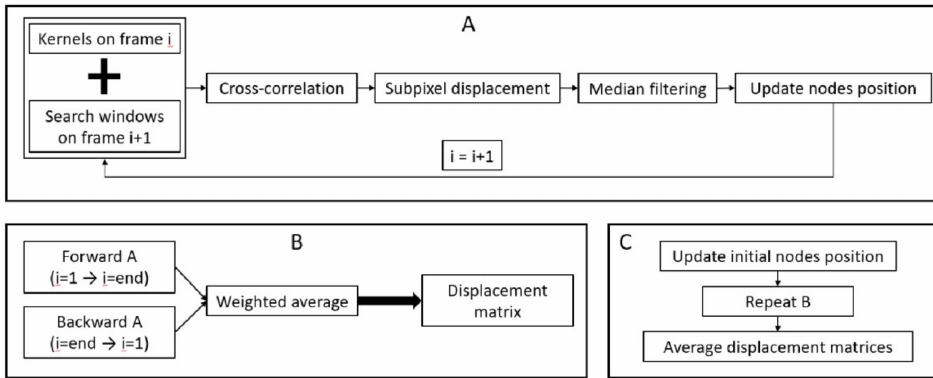
Figure 4. Schematic of the speckle tracking approach implemented for each trial. For each frame, the tracking of node positions is performed based on the normalized cross-correlation of the ra- diofrequency data ( A ). This tracking is performed in the forward and backward directions; after which, a weighted average is performed to obtain a displacement matrix ( B ). Finally, the initial nodes position is slightly modified ( ± 0.5 mm along the x-axis of the image and ± 0.5 or ± 0.3 mm along the y-axis of the image for the lateral collateral ligament (LCL) and medial collateral ligament (MCL) respectively); the complete process is repeated, and all displacement matrices are averaged to obtain the final displacement matrix for the trial ( C